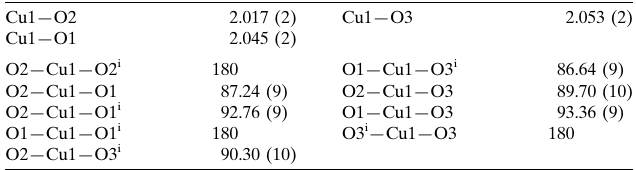
Selected geometric parameters (A˚ , (cid:2) ).